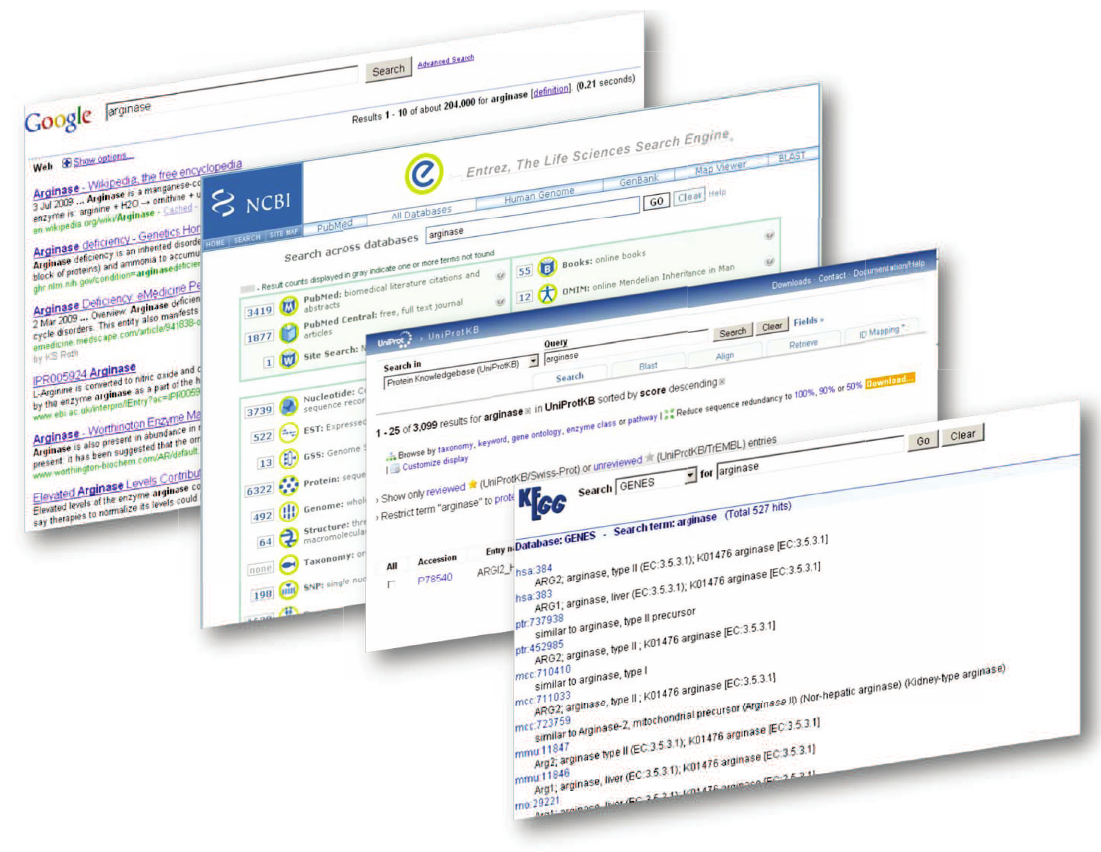
Figure 1: Search Engines in Life Science – the screenshots show examples of popular search en- gines, to investigate protein function: Google, Entrez, UniProt and